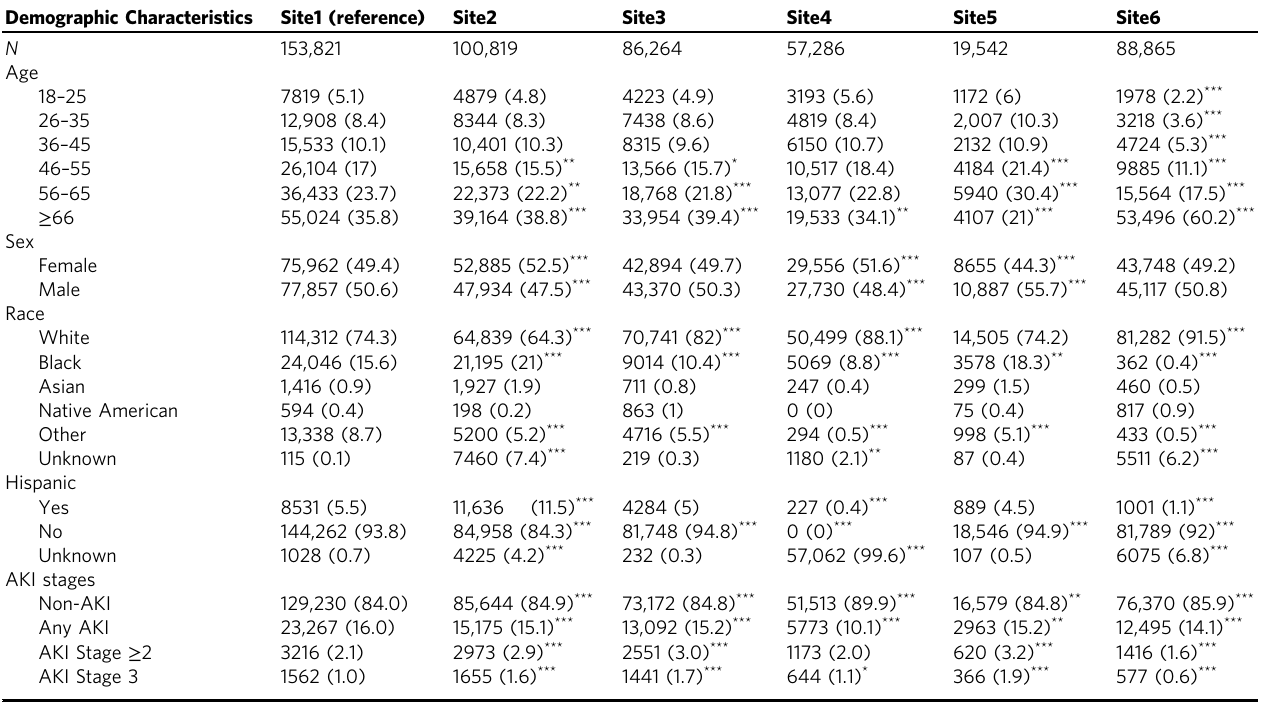
Table 1 Demographic characteristics at different health